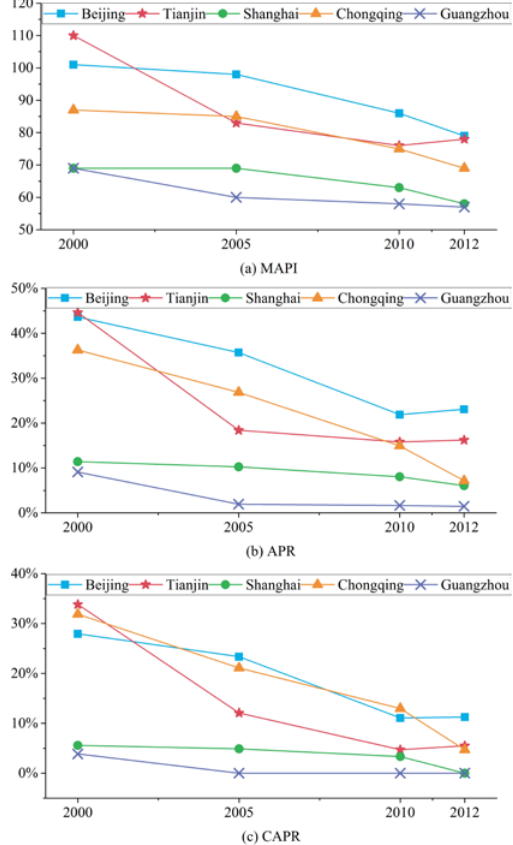
Figure 3. Air pollution in five Chinese megacities: ( a ) MAPI; ( b ) APR; and ( c ) CAPR, 2000–2012.